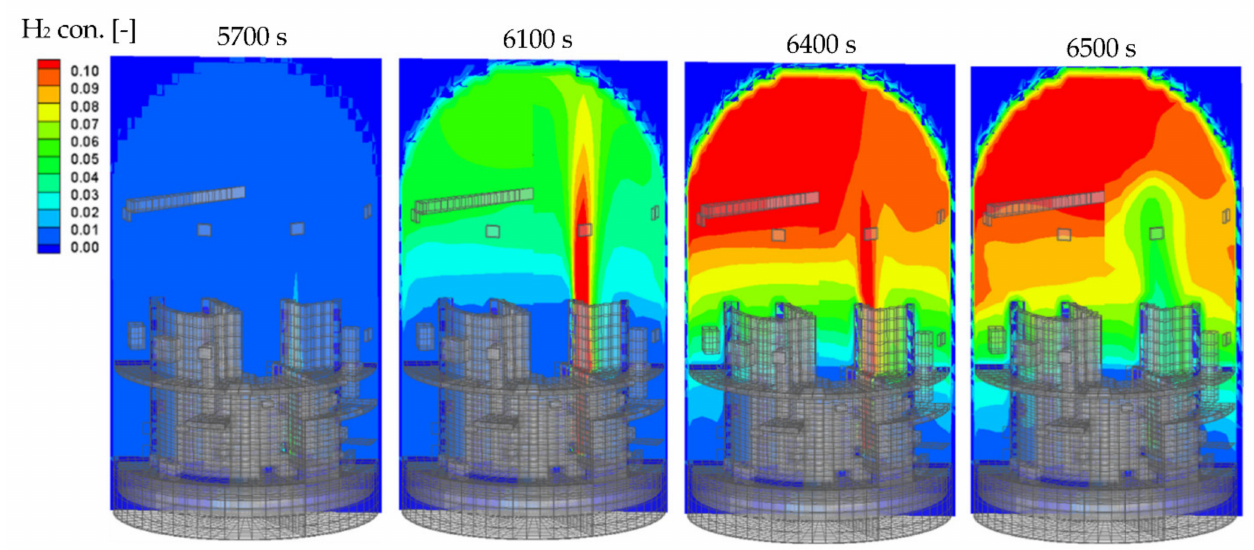
Figure 5. GASFLOW results for the